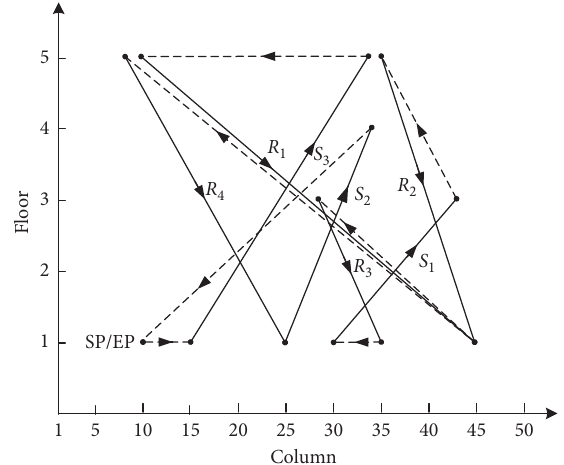
Figure 11: An example with two subloops: the horizontal axis and the vertical axis represent the column and floor, where the stacker access point is located, respectively, the solid line represents load travel, and the dotted line represents no-load travel.